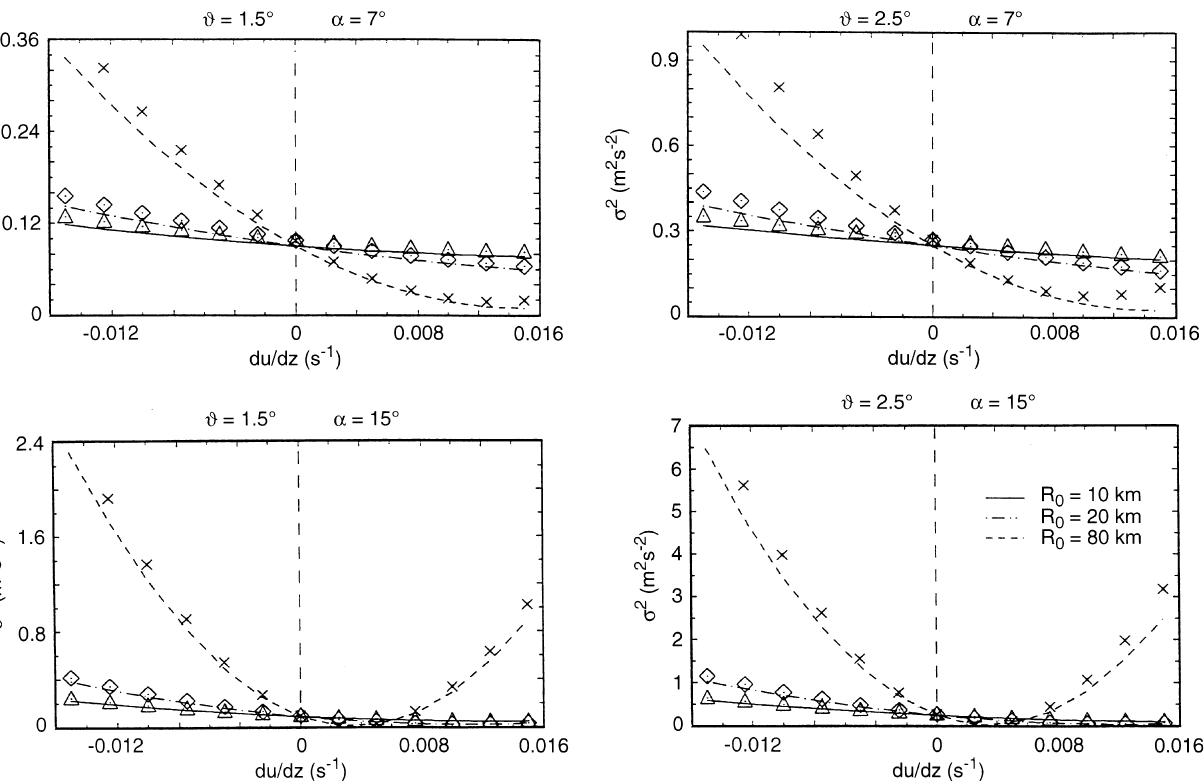
Fig. 3. Changes of the expected spectral broadening as a function of vertical shear of the horizontal wind for typical tropospheric, stratospheric, and mesospheric ranges (cid:133) R o (cid:134) . Panels are for half-beamwidths of 1.5 and 2.5 degrees, and zenith distances of 7 and 15 degrees. The lines (symbols) are solutions of the 2-dimensional (3-dimensional) model. For all cases, u o (cid:136) 20ms (cid:255) 1